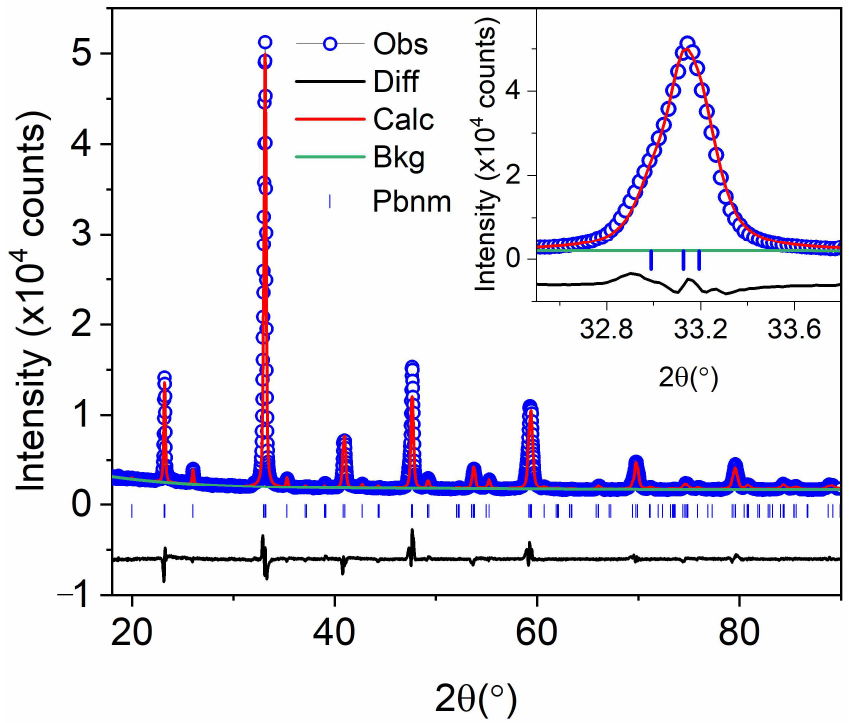
Figure 2. Rietveld refinement of in-house PXRD ( λ = 1.5418 Å) of pulverized as-grown crystals of NdNiO 3 . Obs: observed intensity; Diff: difference; Calc: calculated intensity; Bkg: background. Table 1. Growth conditions of NdNiO 3